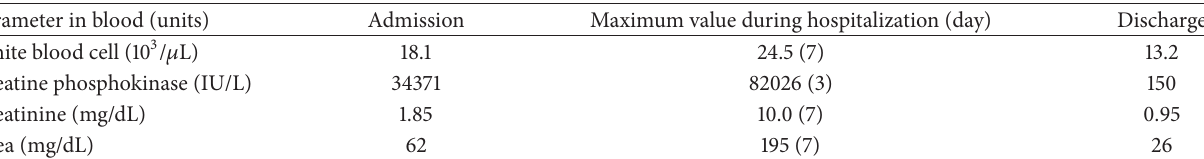
Table 1: Patient’s main laboratory findings on admission and discharge, as well as maximum values observed during hospitalization. Interestingly, the decrease in number of WBC was observed after initiation of azithromycin on day 7, suggesting a probable Legionella resistance to moxifloxacin.